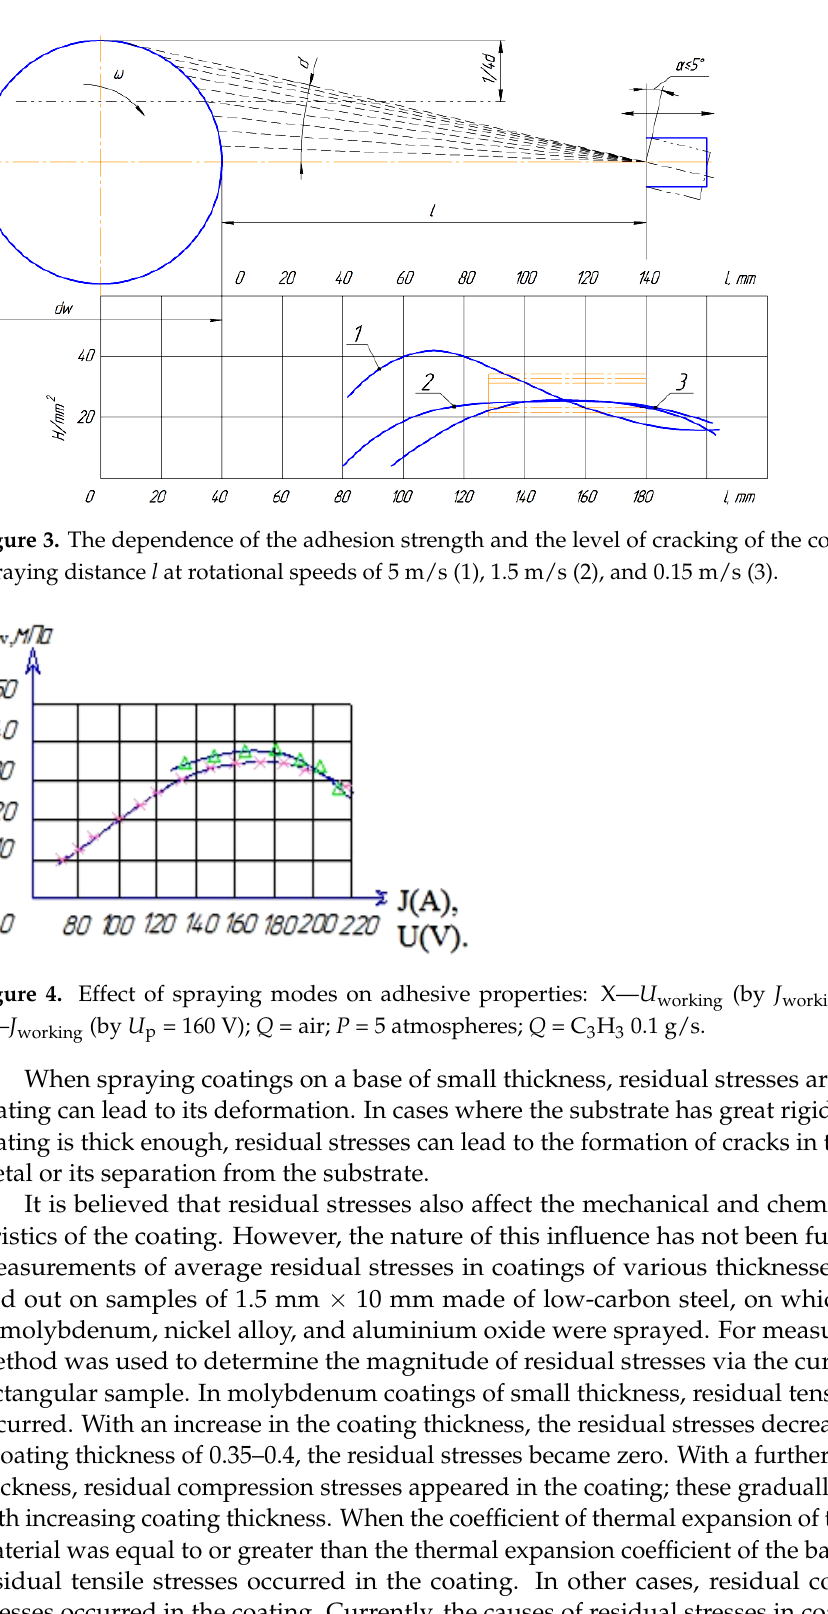
Figure 4. Effect of spraying modes on adhesive properties: X— U working (by J working = 180 A); ∆— J working (by U p = 160 V); Q = air; P = 5 atmospheres; Q = C 3 H 3 0.1 g/s.